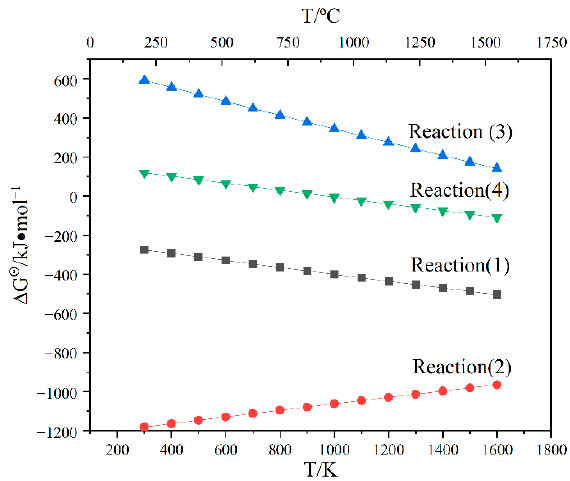
Figure 12. Gibbs free energy versus temperature for chemical reactions.